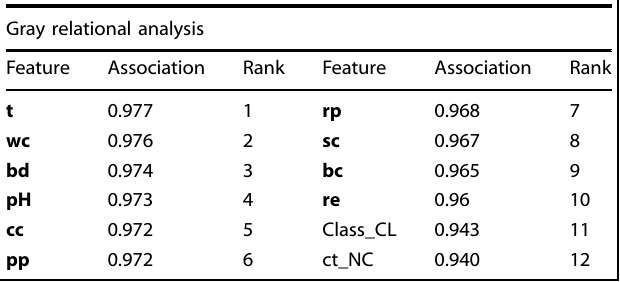
Table 4. The result of gray relational